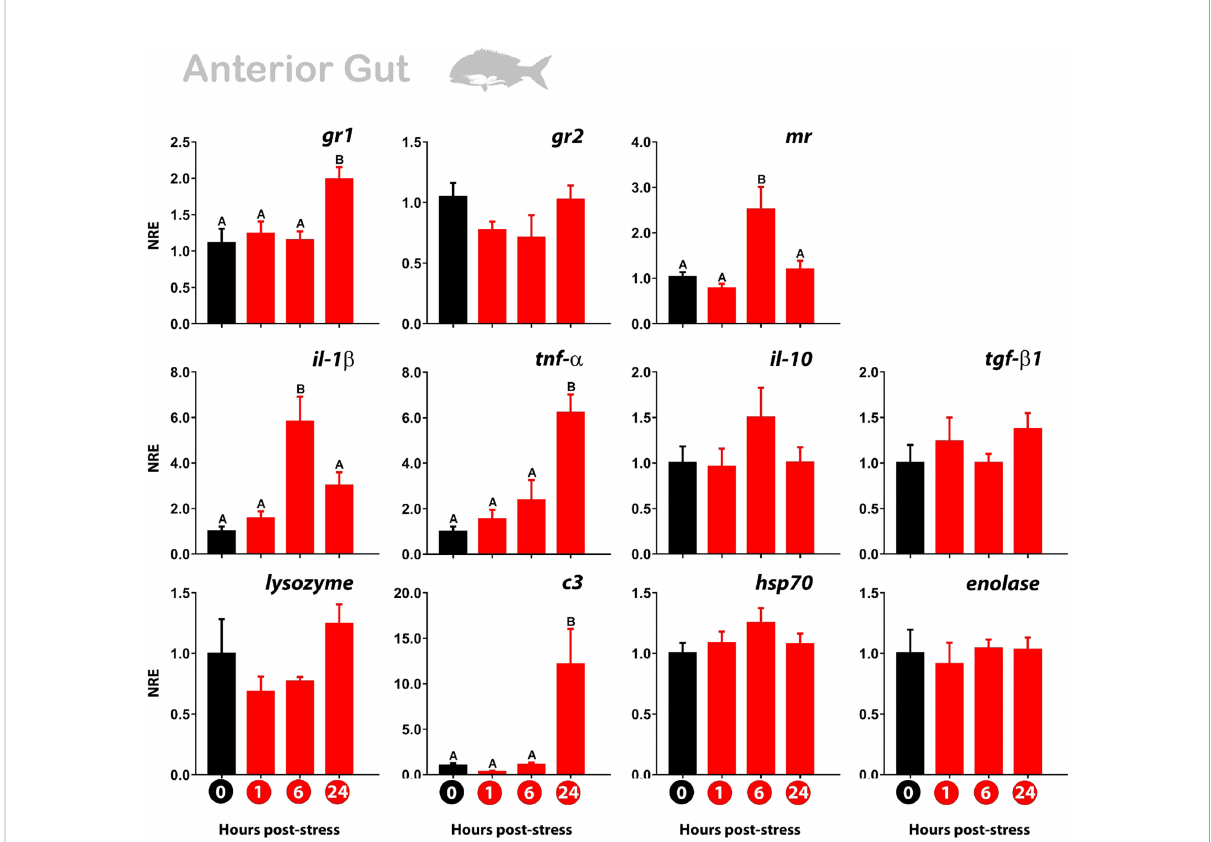
FIGURE 4 Normalized gene expression (NRE) pro fi le in the anterior gut of gilthead sea bream subjected to acute stress by air exposure. Modulation of cortisol receptors ( gr1 , gr2 , mr ), immune ( il-1 b ; tnf- a ; il-10 ; tgf- b 1 ; lys ; c3 ), and stress response ( hsp70 ; enolase ) were evaluated by RT-qPCR. Bar values represent the mean ± standard error (n = 8 fi sh per treatment and time evaluated). Time zero represents the control group (non- stressed fi sh; black bar). The modulation of gene expression at 1 hour, 6 hours, and 24 hours post-stress (red bars) is represented. The rpl27 was used as reference gene. The signi fi cant differences between the different times are presented with a capital letter on each bar. The absence of letters indicates that there are no signi fi cant differences in the times evaluated (one-way Anova; p<0.05). gr1 , glucocorticoid receptor 1; gr2 , glucocorticoid receptor 2; mr , mineralocorticoid receptor; il-1 b , Interleukin 1-beta; tnf- a , tumor necrosis factor-alpha; il-10 , interleukin 10; tgf- b 1 , tumor growth factor-beta; lys , lysozyme; c3 , complement protein c3; hsp70 , heat shock protein